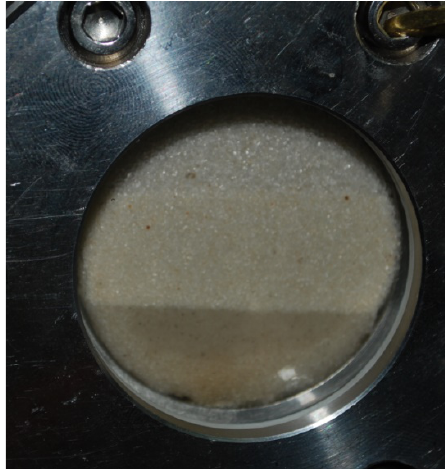
Figure 2. Visual window diagram.